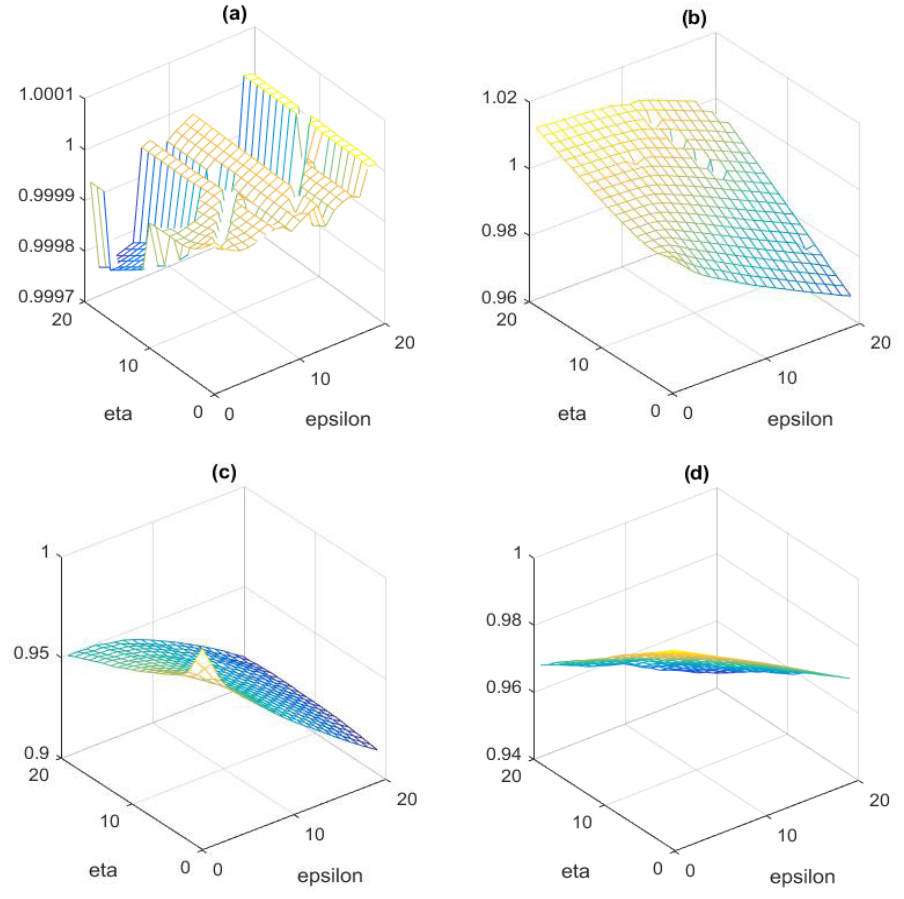
Figure 6. Texture roughness under different background. Among them, ( a – d ) represent the background of low contrast, the port scene, complex sea surface, and cloud